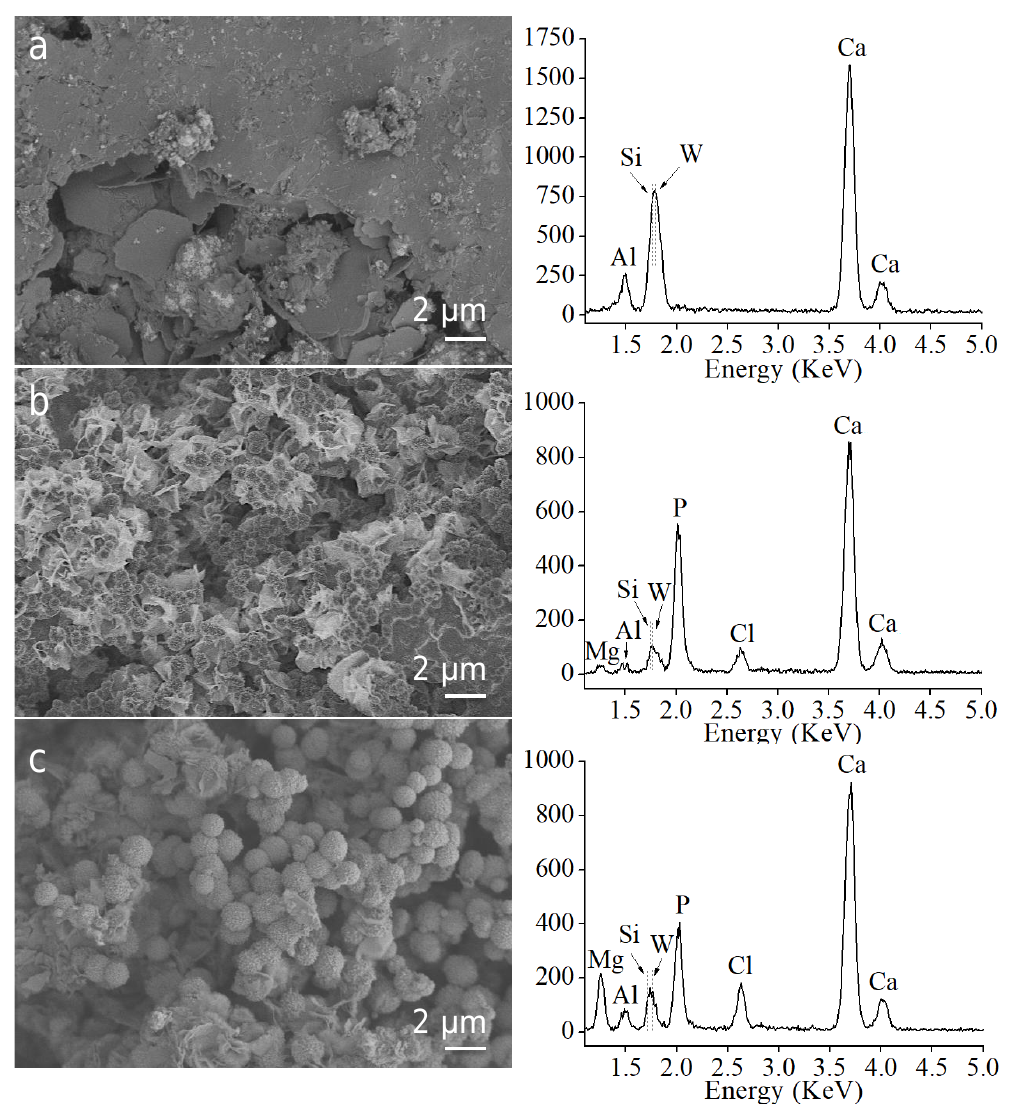
Figure 7. FEG-SEM observations (left) and EDX analysis (right) of the MTA Repair HP set material after simulated body fluid (SBF) bioactivity assay: ( a ) un-treated; ( b ) after 24 h soaking; ( c ) after 72 h soaking. The y-axis values of EDX plots correspond to acquired energy counts.